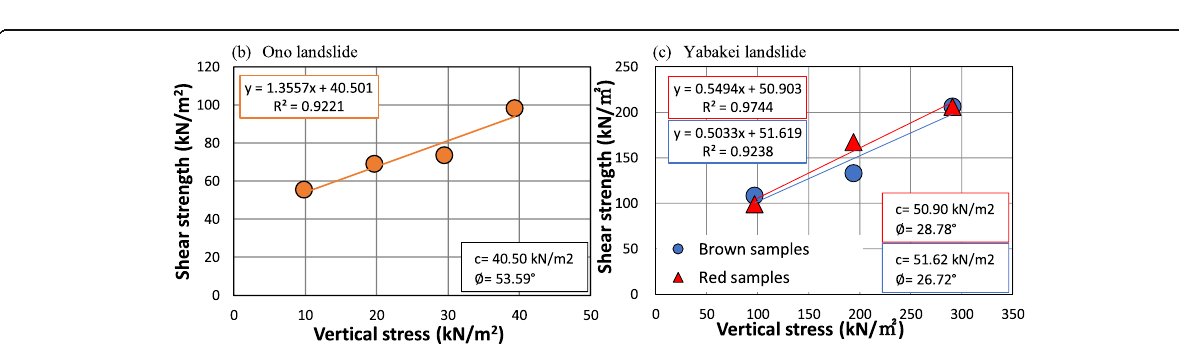
Fig. 14 Relation between maximum shear stress and vertical stress in soil materials in ( b ) Ono landslide and ( c ) Yabakei